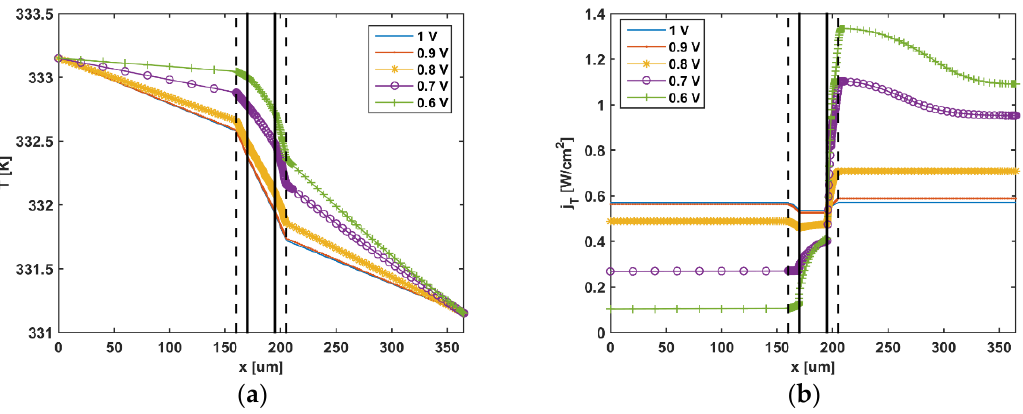
Figure 7. Thermal profiles along through-plane ( a ) temperature distribution; ( b ) heat flux profile.